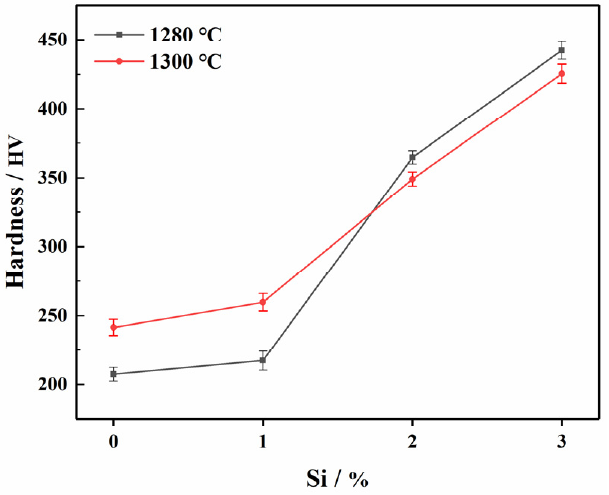
Figure 12. Hardnessof ODSsteels with0, 1%, 2%and 3%wtSi at1280 ◦ C and1300 ◦ C sintering temperature. Figure 12. Hardness of ODS steels with 0, 1%, 2% and 3%wt Si at 1280 °C and 1300 °C sintering